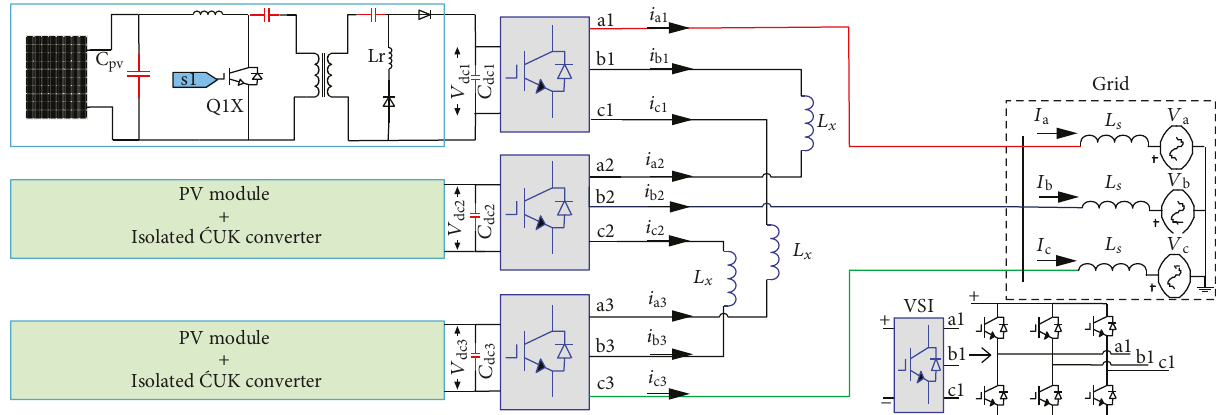
Figure 14: Experimental setup of con fi guration